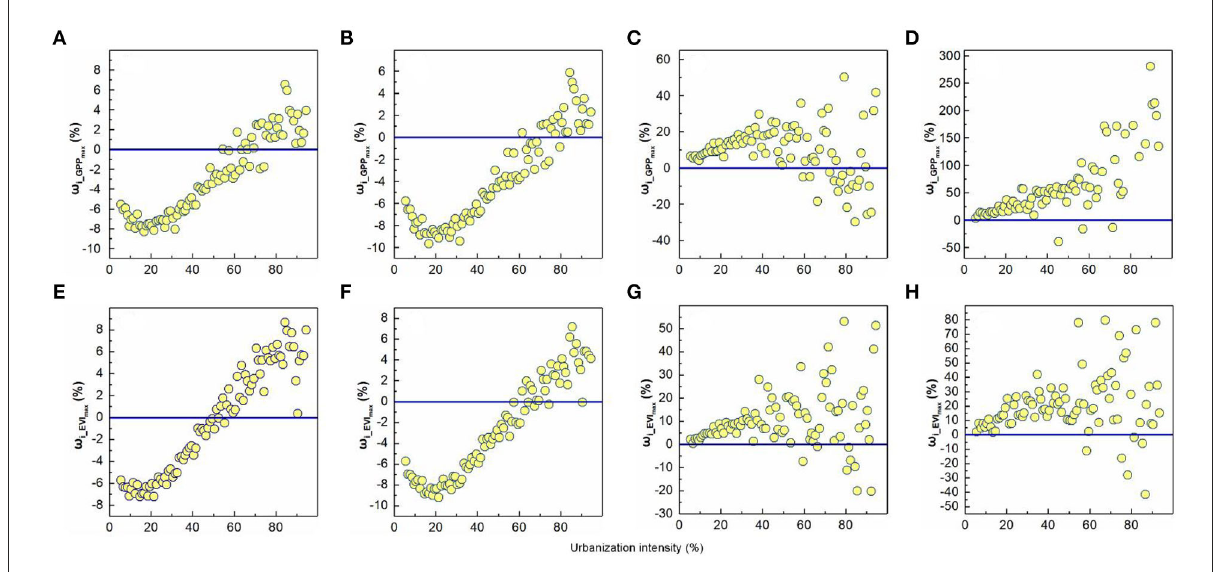
FIGURE4 Relative indirect impacts of urbanization on GPP max and EVI max along the urbanization gradient in the whole area (A,E) , forest (B,F) , grassland (C,G) , and wetland areas (D,H) in 2020.